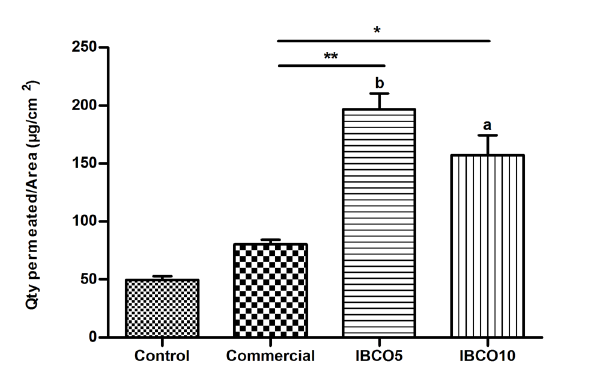
FIGURE 2 - Cutaneous permeation of ibuprofen (IBU) through pig skin at 450 min in vertical diffusion cells. *p < 0.05; **p < 0.01 in comparison with Commercial product; a p < 0.05 and b p < 0.01 in comparison with control (CO) (n=3).